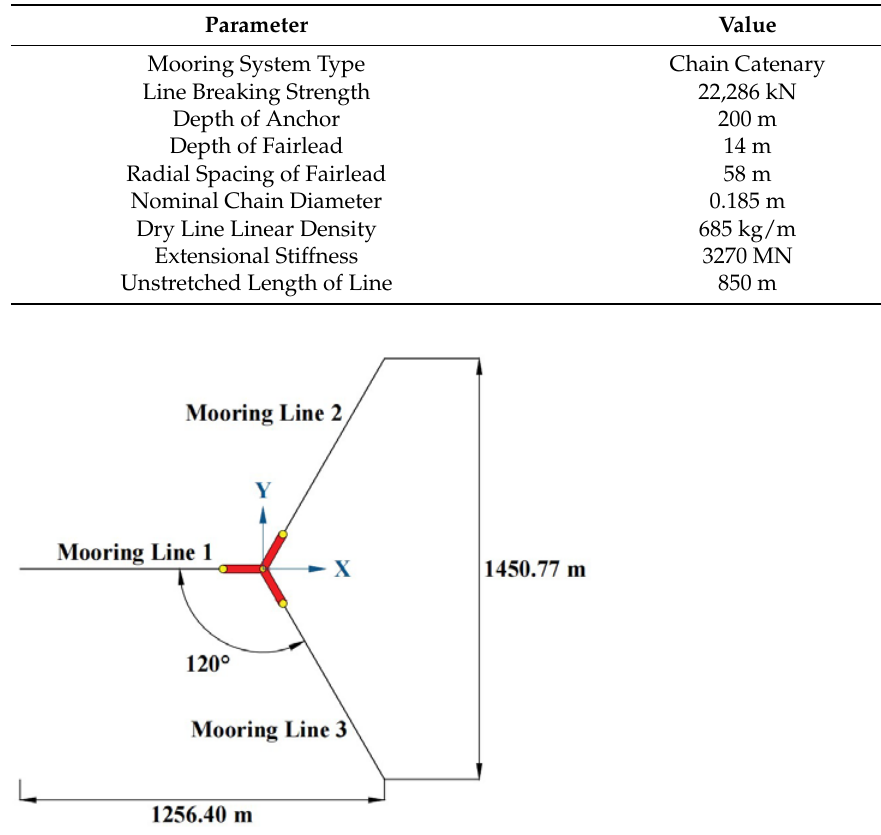
Table 3. Properties of the mooring system.